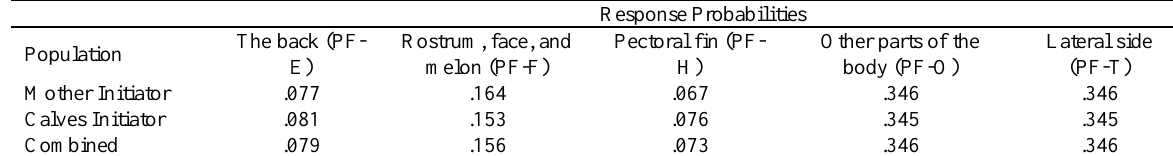
Probability of Starting an Interaction by Touching Specific Body Parts by Mothers and Their Calves